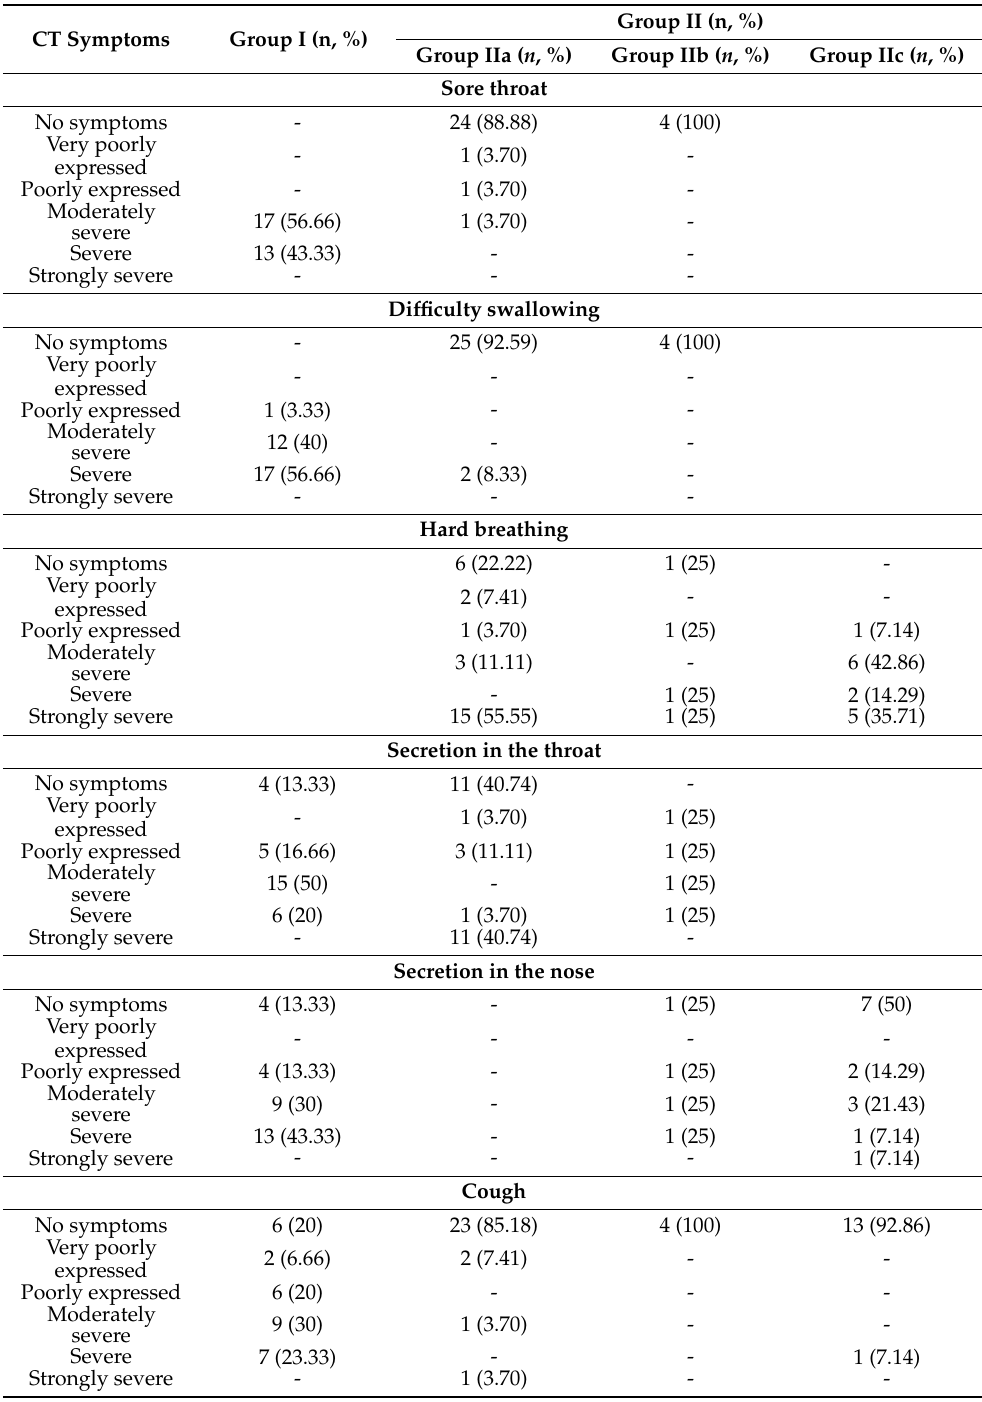
Table 2. Clinical data of 75 studied patients with chronic